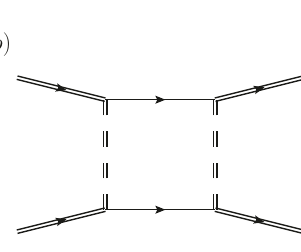
Figure 2 . Additional diagrams for F (cid:22) F and FF annihilations induced by the Yukawa interaction. Solid double lines stand for F , solid thin line for the SM quark and double dashed line for the scalar DM. The colour (cid:13)ux is di(cid:11)erent from the diagrams induced by